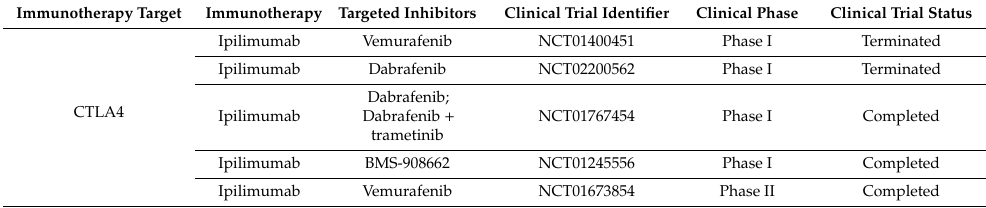
Table 1. Summary of clinical trials utilizing MAPK pathway targeted therapy in combination with checkpoint